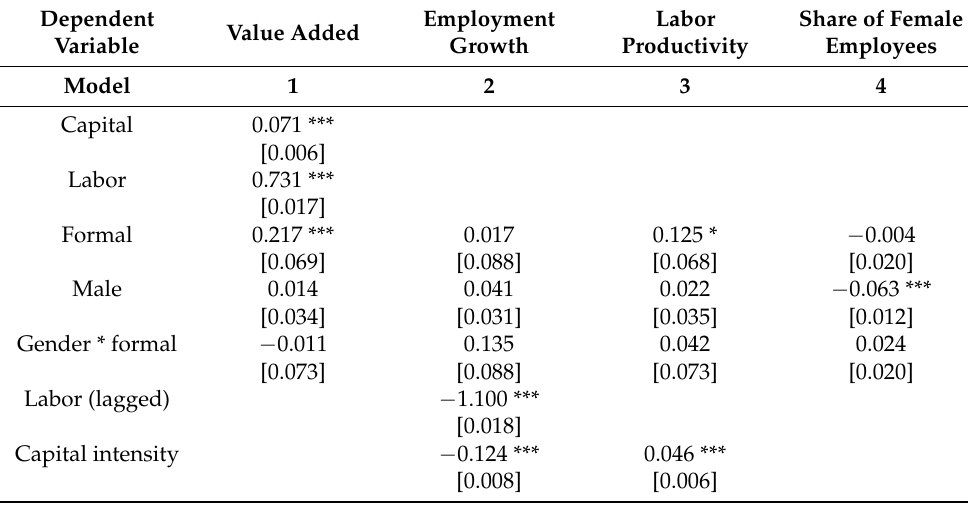
Table 9. Fixed-effects models with interaction terms between formality and gender.